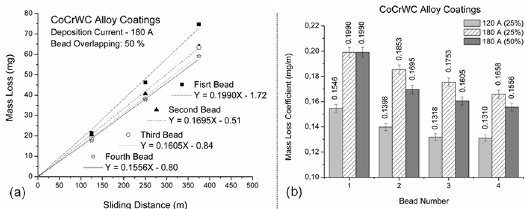
Figure 13. Mass loss versus distance for 180 A / 50 % overlapping and (b) Mass Loss Coefficient